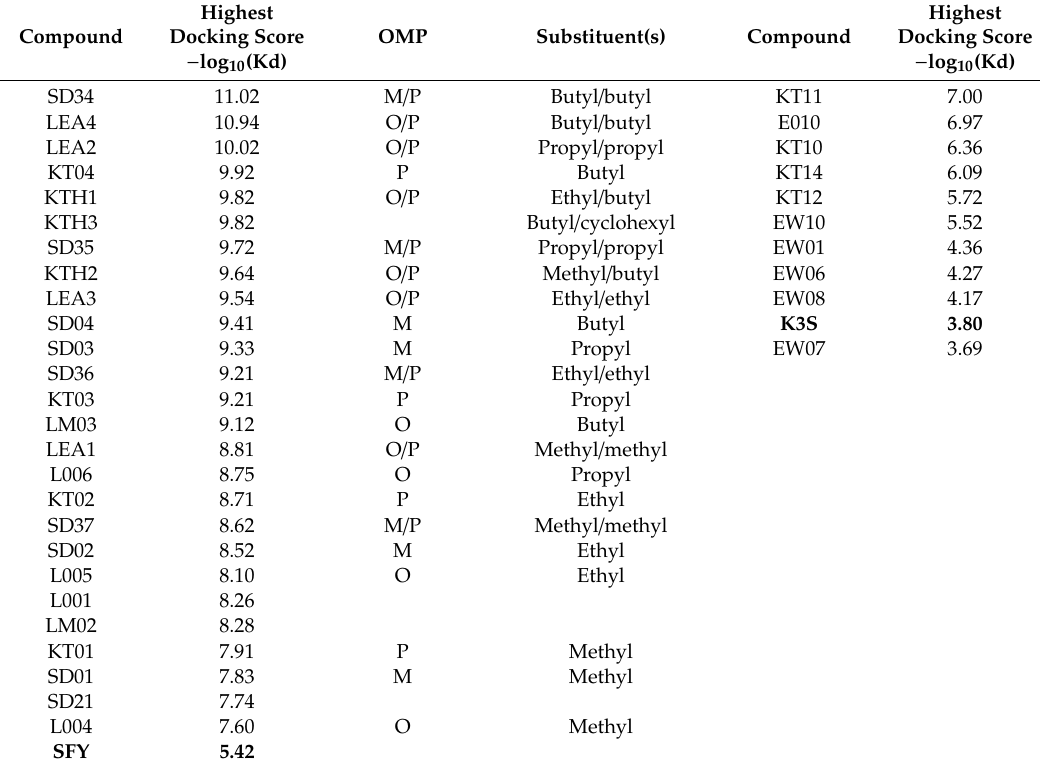
Table 6. Docking Scores of SFY and K3S derivatives having aliphatic